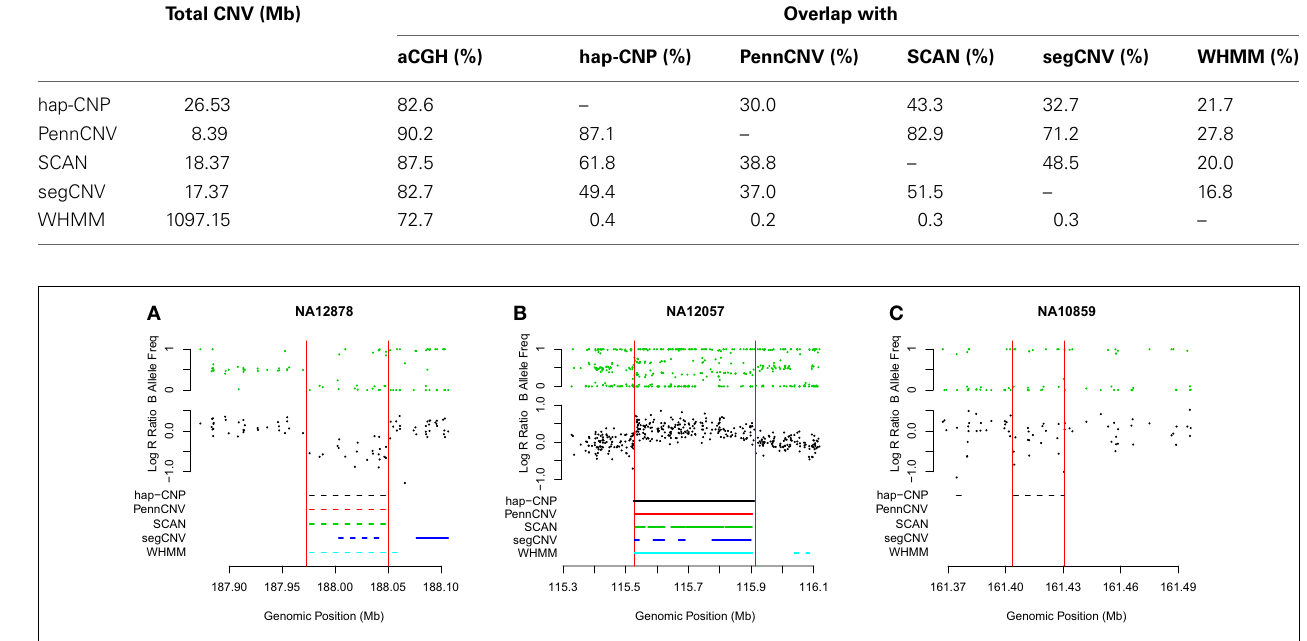
Table 7 | Number of CNV calls on chromosome 1 of CEU samples.